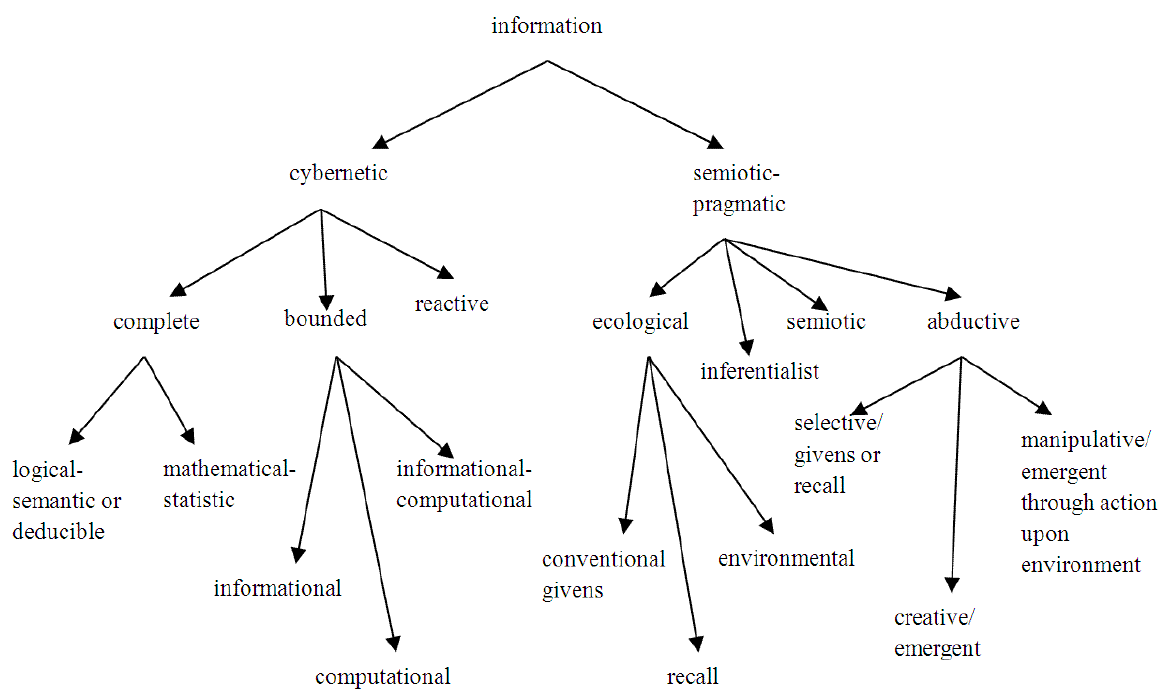
Figure 3. Various conceptualizations of